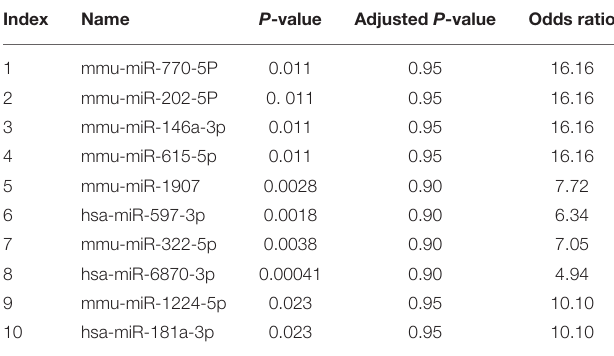
TABLE 5 | Identification of target miRNA of differentially expressed genes (DEGs) (miRtargetBase 2017).